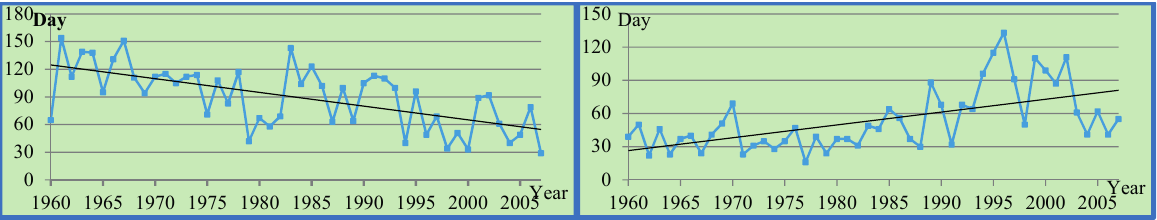
significant positive trend with a slope of 1.1178 ( right ) of the CDD index.